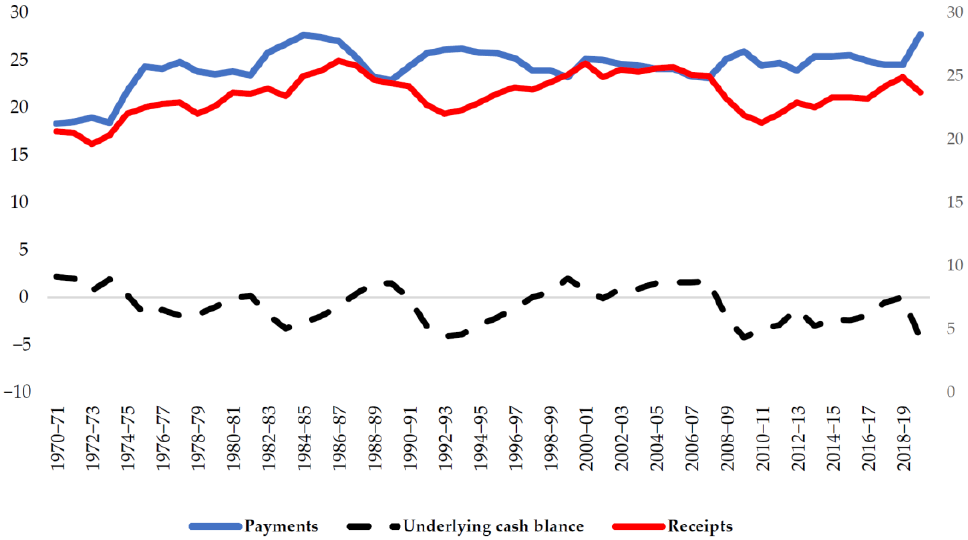
Figure 1. Australian Government general government sector receipts percent of GDP, payments percent of GDP, and underlying cash balance percent of GDP. Source: Australian Government, budget strategy and outlook: budget paper no. 1: